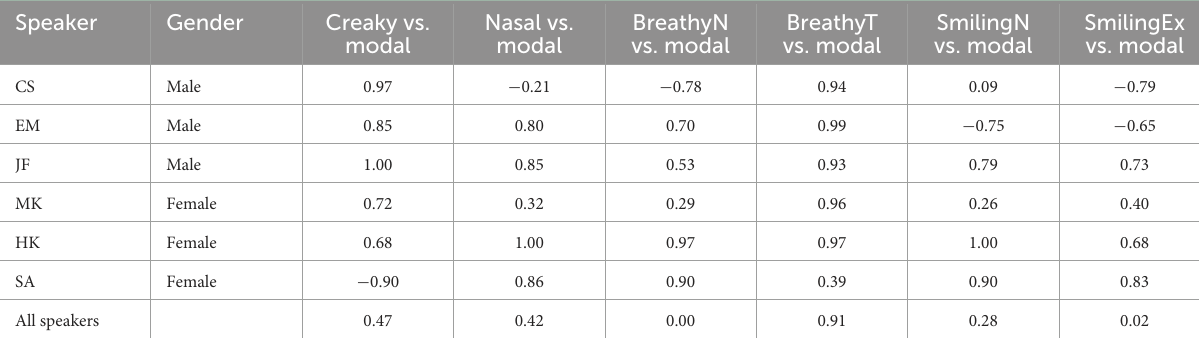
TABLE 1 Correlation coefficients for modal voice vs. all other examined vocal qualities (i.e., correlating Modal-Creaky, Modal-Nasal, Modal-BreathyNatural, Modal-BreathyTechnical, Modal-SmilingNatural, Modal-SmilingExtreme), calculated separately for each speaker and combined for the six